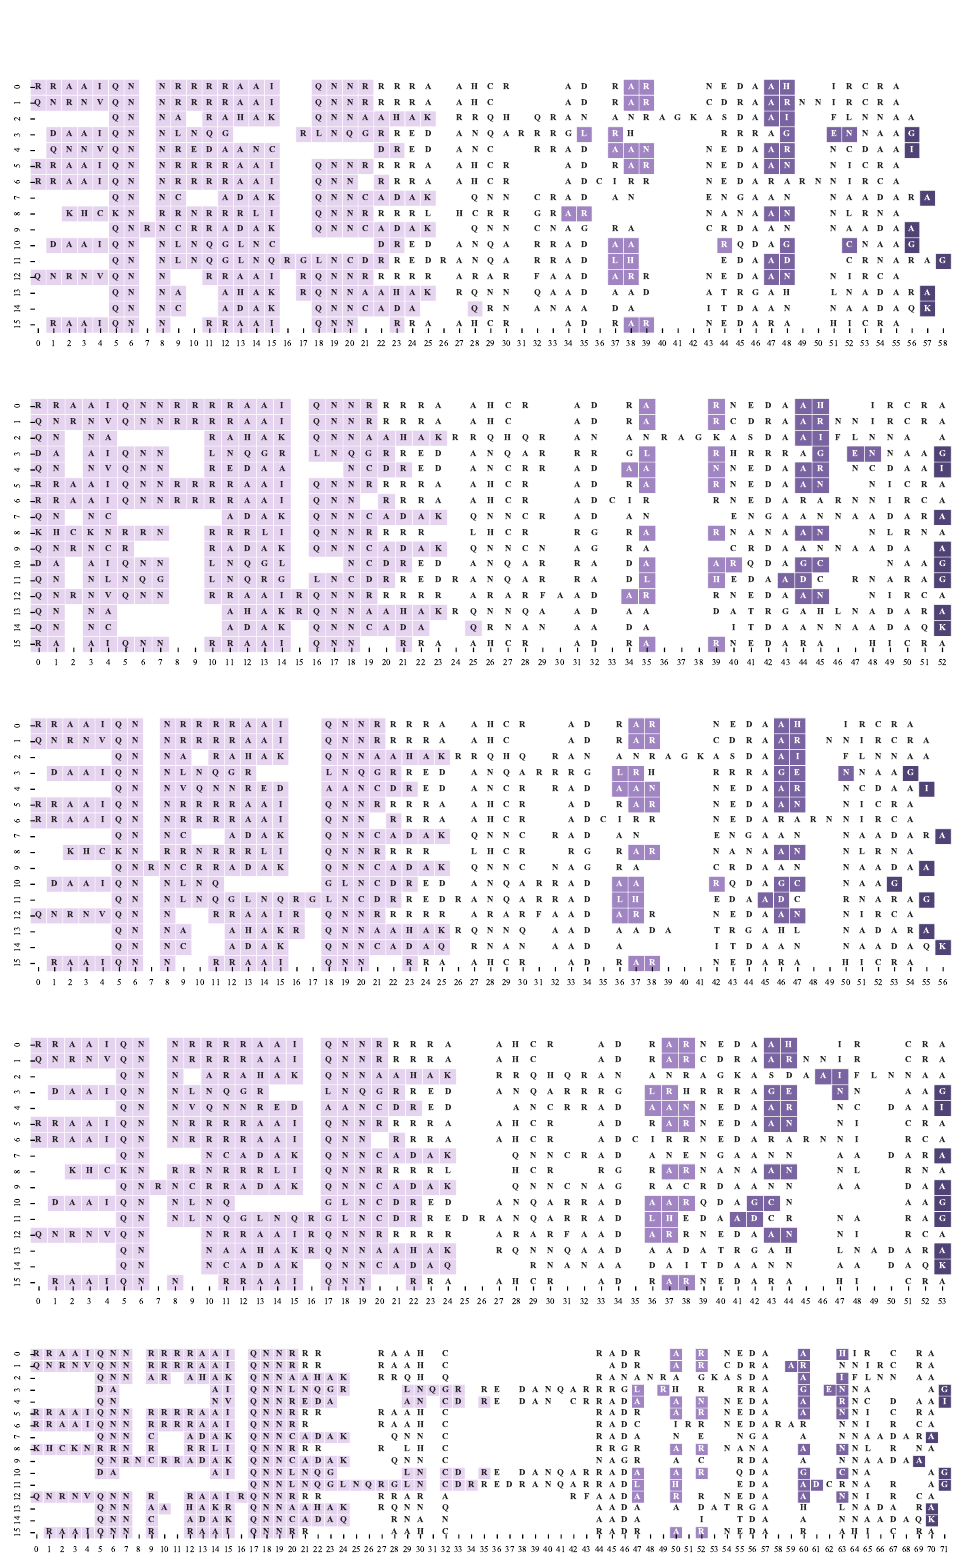
Figure 2. Automatically aligned melodic sequences of the tune family “Daar ging een heer” using the following configurations ( top – bottom ): M AFFT - genafpair -4.-2., M AFFT - globalpair-allowshift -4.-2., M AFFT - loacalpair -2.-1.5, M AFFT - localpair-allowshift -3.-1.5 and T-C OFFEE -8-0.5. Colours correspond to motif labels. White colour indicates no motif